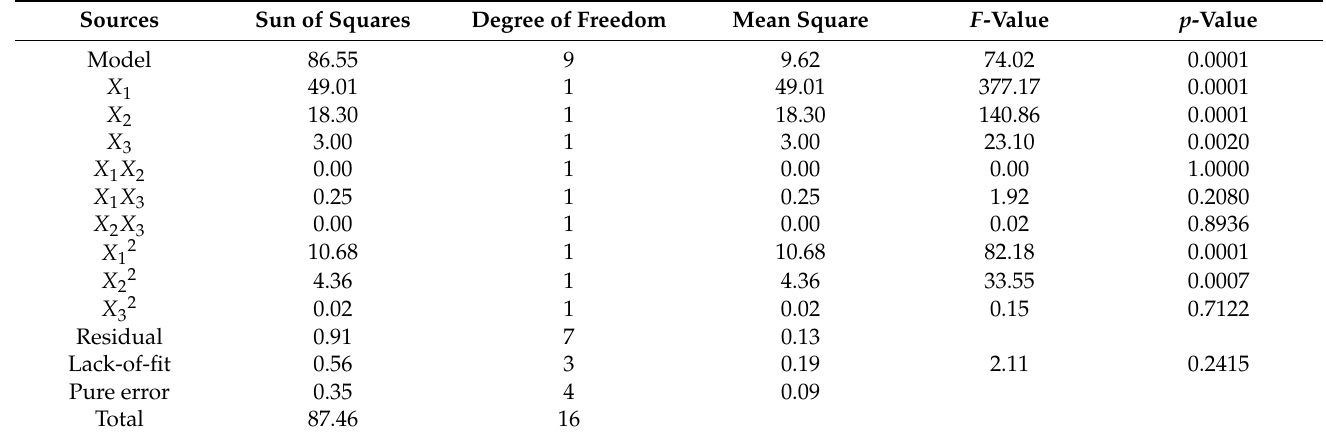
Table 5. ANOVA of the harvesting rate of ripe fruit.